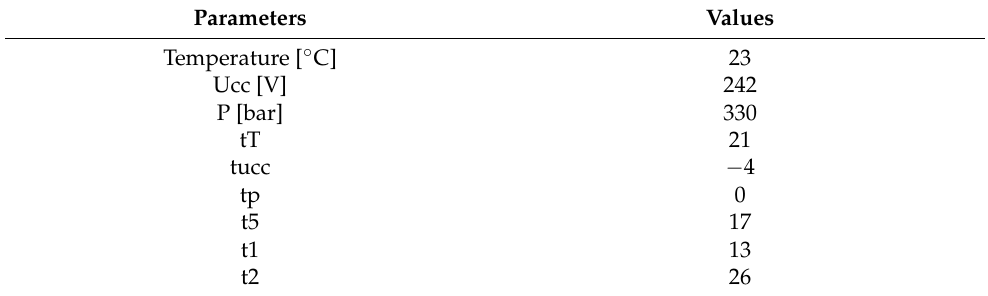
Table 5. The main parameters used in simulation of disconnection process of the circuit-breaker.